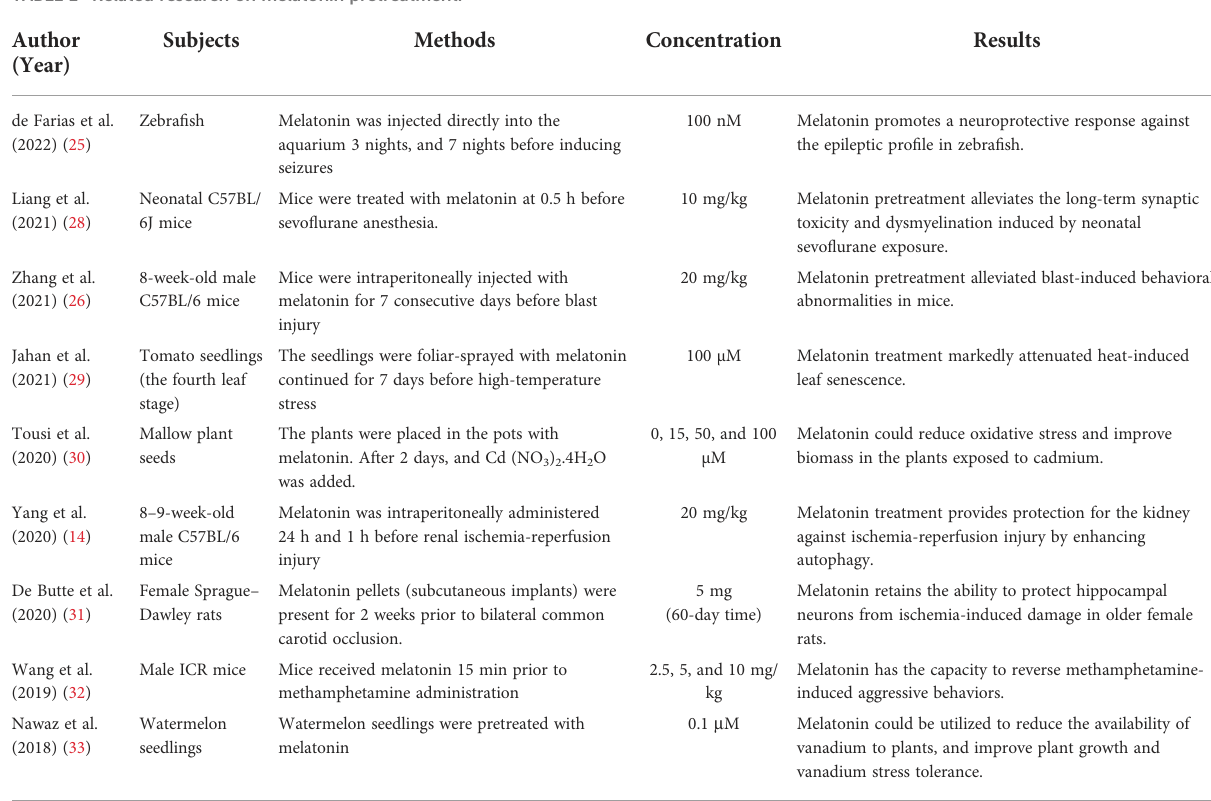
TABLE 1 Related research on melatonin